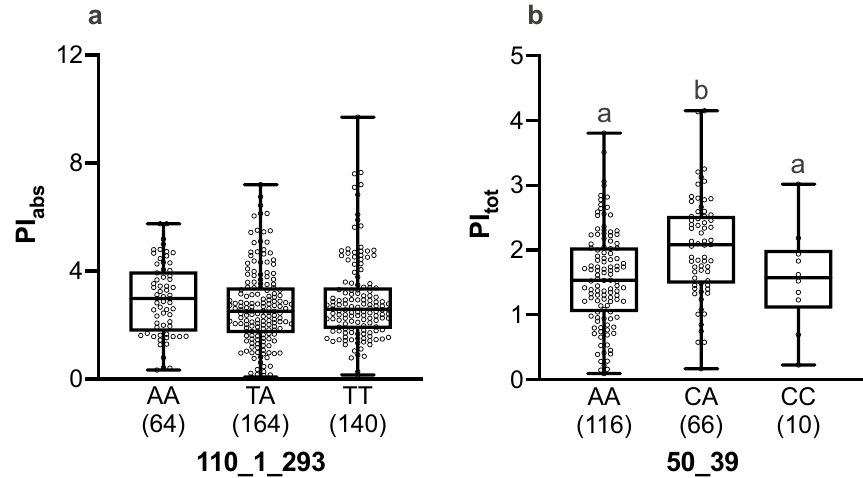
Figure 3. Chlorophyll fluorescence parameters PI abs ( a ) and PI tot ( b ) measured in homozygote (AA and TT) and heterozygote (TA) genotypes of the A/T SNP 110_1_293 ( a ) and in homozygote (AA and CC) and heterozygote (CA) genotypes of the A/C SNP 50_39 ( b ) that were significantly associated with these parameters under control/acidic ( a ) and drought/acidic ( b ) soil conditions, respectively. Different letters (a and b) above whiskers indicate significant differences ( P < 0.05). Box plots present median, upper and lower quartiles; whiskers show minimum and maximum values. Sample size is presented in